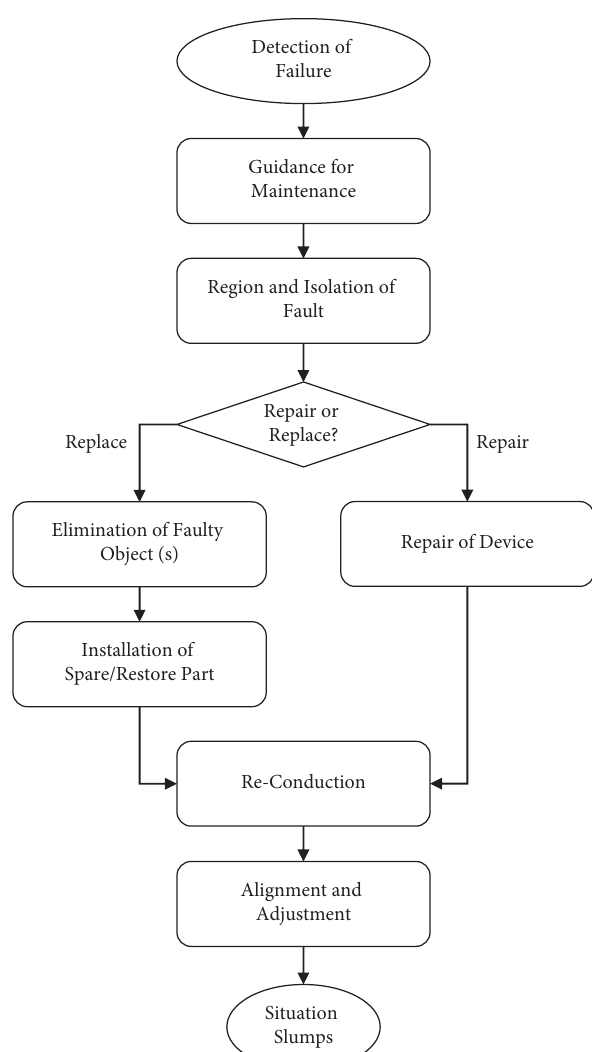
Figure 5: Maintenance cycle of industrial